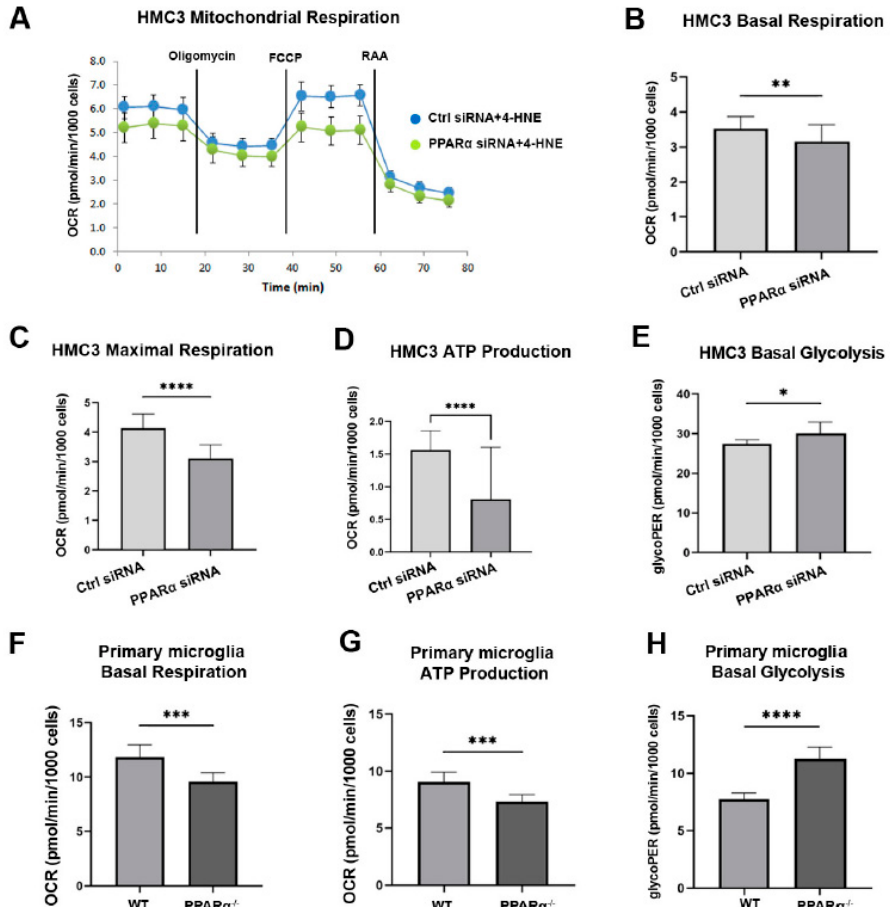
Figure 6. Altered metabolic profile with Ppar α deletion. ( A ) Representative real-time trace of oxygen consumption rates (OCR) using a Mito stress test in human microglia exposed to 4-HNE for 24 h following Ppar α siRNA knockdown. ( B – D ) Quantification of basal OCR ( B ), Maximal respiration ( C ), and ATP production ( D ) in Ppar α siRNA knockdown HMC3 cells relative to HMC3 cells transfected with scramble siRNA, n = 5–8. Student’s t -test. * p < 0.05, ** p < 0.01. ( E ) Glycolytic proton efflux rate (glycoPER) measurement obtained from microglia cells exposed to 4-HNE for 24 h following Ppar α knockdown and subject to the glycolytic rate assay. n = 5–8. * p < 0.05, Student’s t -test. ( F , G ) Mito stress test assay in mouse WT and Ppar α − / − mouse primary microglial cells exposed to 4-HNE for 24 h. Quantification of basal OCR ( F ) and ATP production ( G ). ( H ) Glycolytic rate assay in